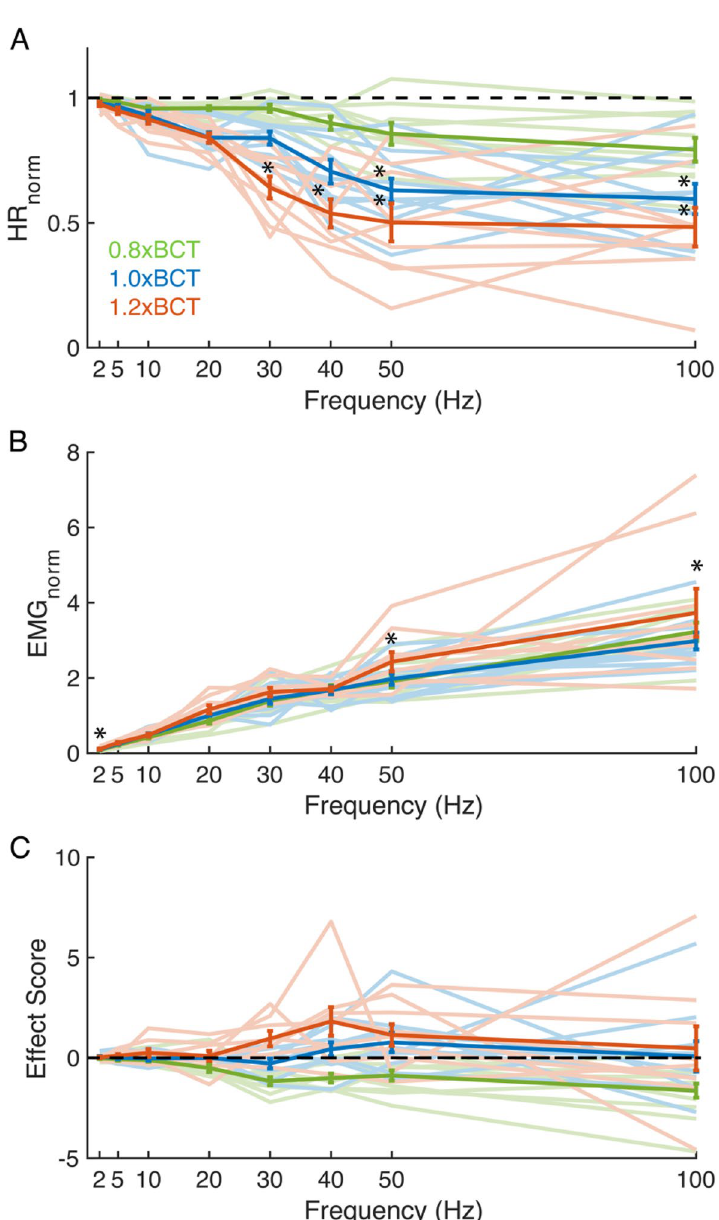
Fig. 2 In vivo responses to constant frequency stimulation (intra-burst frequency (Hz) equals mean pulse rate (pulses/s)) of the mouse right cervical vagus at amplitudes of 0.8xBCT (green), 1.0xBCT (blue), and 1.2xBCT (orange). A Heart rate normalized to pre-stimulation baseline (HRnorm). B EMG normalized to response from stimulation at 1.0xBCT, 20 Hz (EMGnorm). C Effect score combining both heart rate and muscle responses normalized to response from stimulation at 1.0xBCT, 20 Hz. Data are presented as mean standard error with individual animals as light lines, n 9-10/ ± = parameter set. The standard errors at 20 Hz for 1.0xBCT are 0 because those data points were used for normalization. * p < 0.05 in Tukey post-hoc test, comparing to mean responses to stimulation at 1.0xBCT, 20